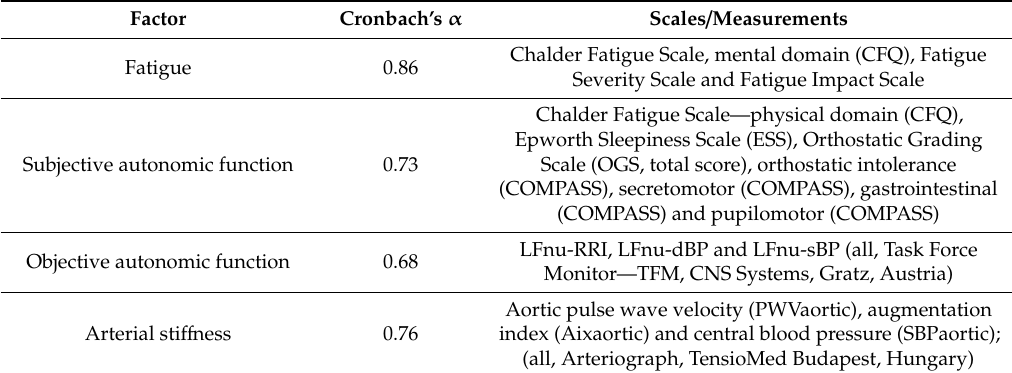
Table 5. Factors emerged from higher-order principal axis factor analysis, n = 102.